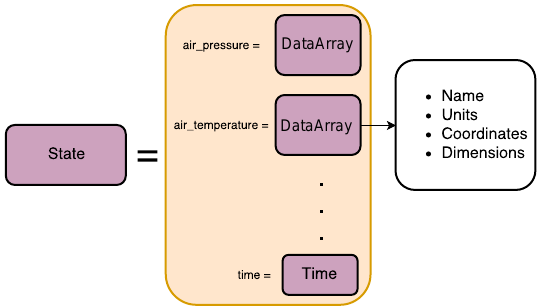
Figure 7. The model state as in the sympl framework. The state in the orange box contains all the information that is stepped forward in time. Each DataArray contains information such as the quan- tity name, units, and